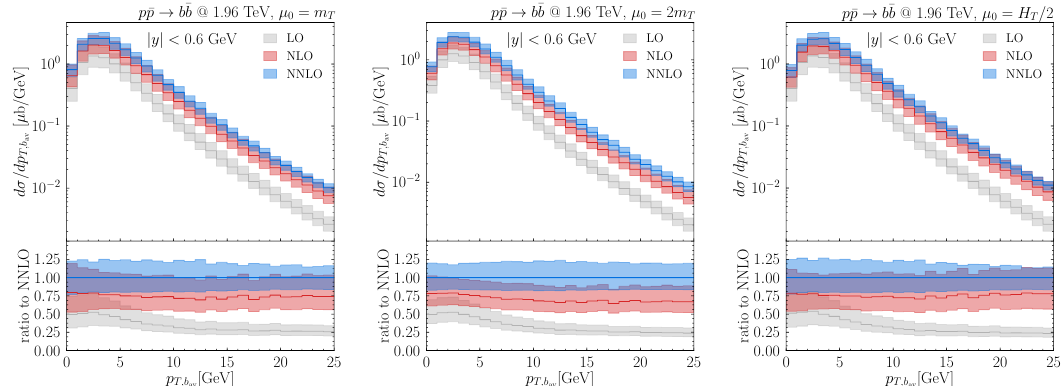
Figure 3 . Transverse momentum distributions at the Tevatron with the rapidity cut the scale choice (cid:22) 0 = m T (left), (cid:22) 0 = 2 m T (central) and (cid:22) 0 = H T = 2 (right). The lower panels show the ratio to the NNLO